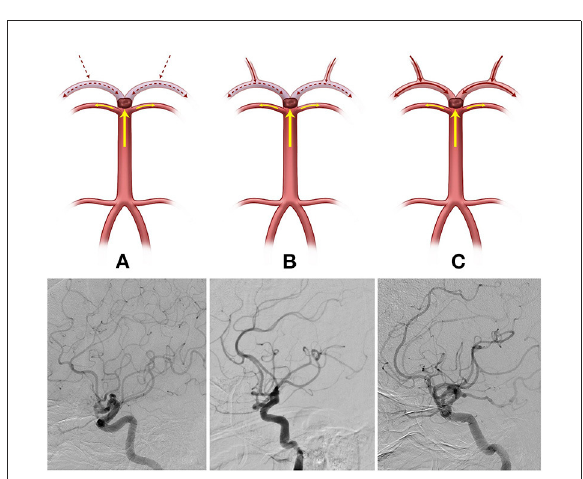
FIGURE2 The posterior communicating artery (PCoA) types were categorized into three groups (Illustrations and angiographies). ( A , Type I) Hypoplastic or non-visible PCoA, ( B , Type II) Normal patency but PCA not visible through PCoA flow on the internal carotid artery angiogram, and ( C , Type III) Good patency with visible PCA or fetal-type